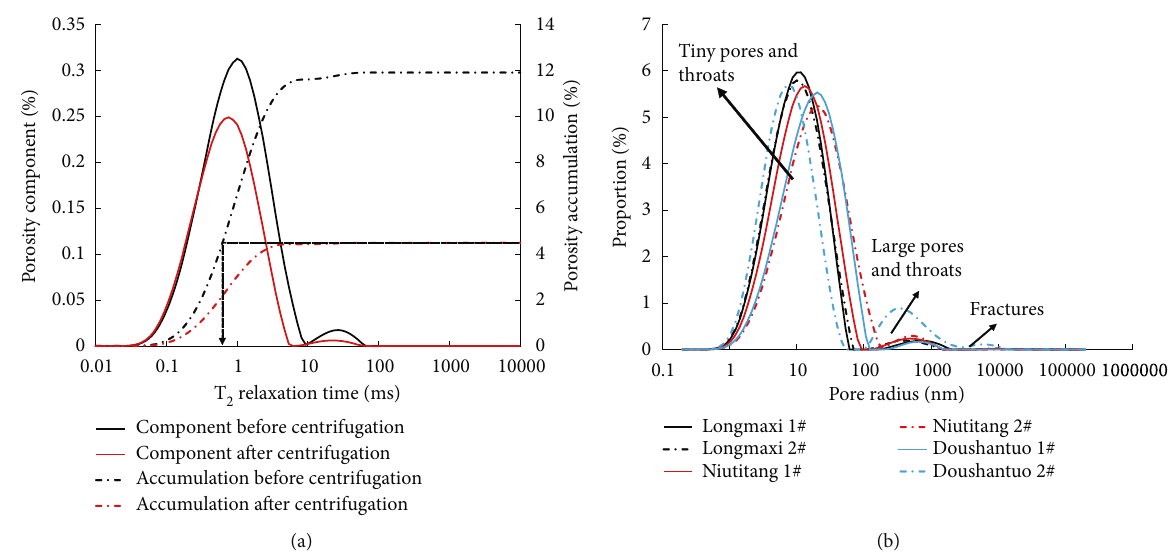
Figure 7: (a) Transformation method of T